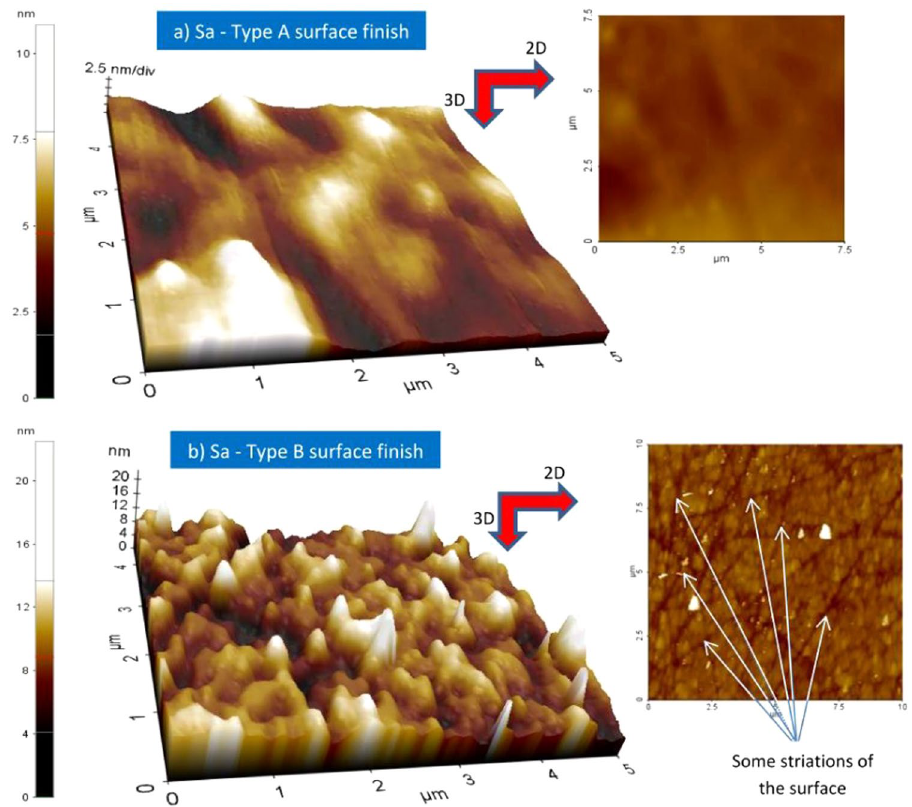
Figure 4. Striations and surface finish. 2D and 3D (zoomed in) surface topography of Sapphire samples of type A ( a ) and type B ( b ) surface finish. Note that the vertical scales are different. The white arrows indicate some striations of micrometric length and width ≪ λ (not exhaustive) that could be correlated with the reduction of LIDT in the case of type B surface finish (see text). The measured area roughly corresponds to a quarter of the typical surface illuminated during the laser